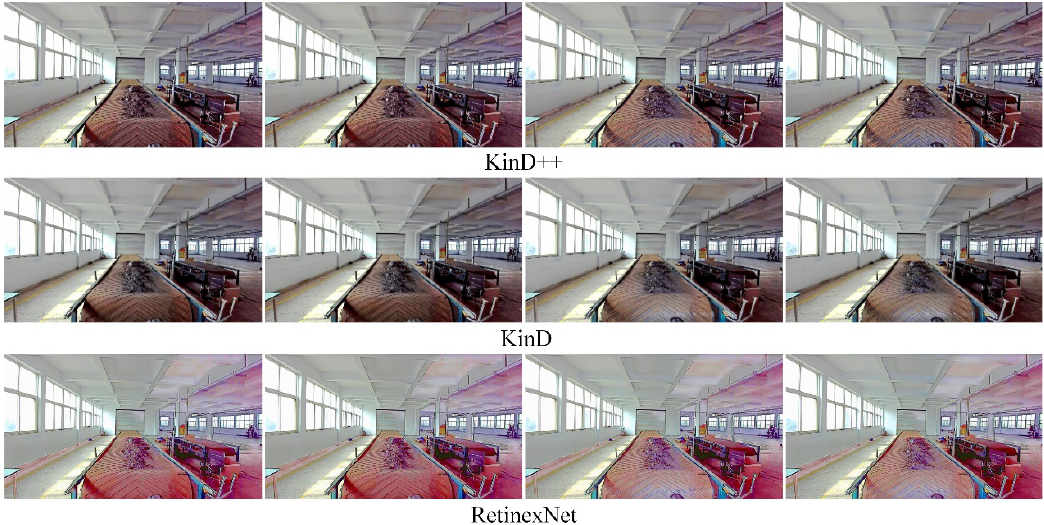
Figure 19. Enhancement of daytime backlit images by deep learning algorithms.